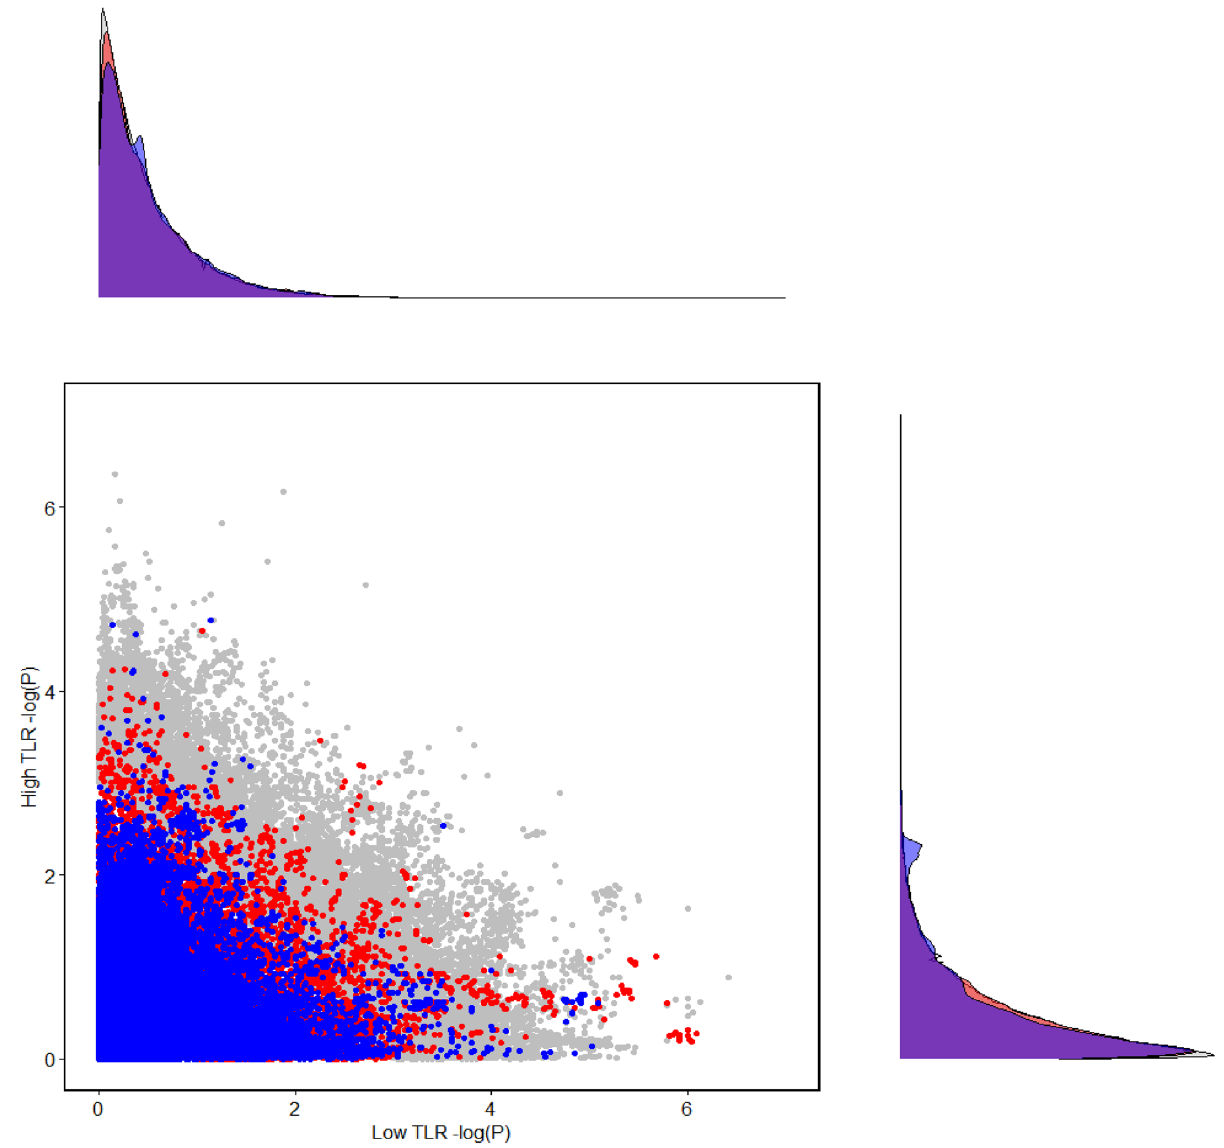
Figure 1. SNP association (p-value) scatterplot for depressive symptoms in low versus high dietary TLR subgroups showing the kynurenine-related SNPs in blue, the serotonin-related SNPs in red, and all the other SNPs in grey on a negative base ten logarithmic scale (− log(P)). TLR denotes dietary tryptophan/large neutral amino acids ratio. Density functions for SNP p-values are displayed on both axes, for kynurenine (blue) and serotonin (red) pathways. Note that the layer of blue dots obscures other dots in the lower left corner of the